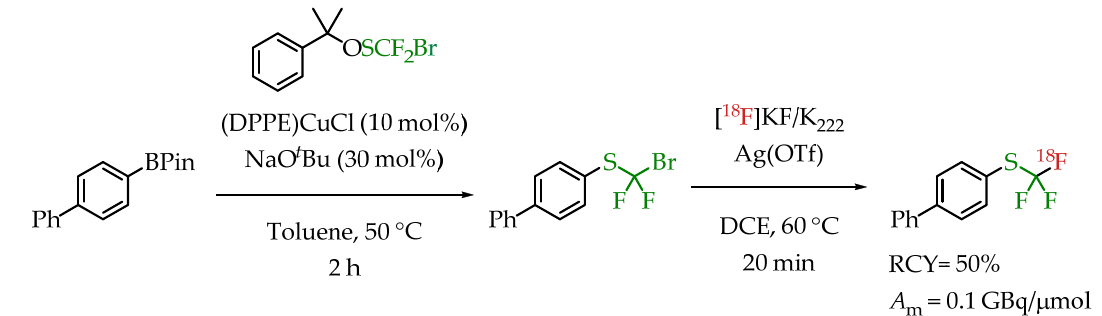
Scheme 19. α -Cumyl bromodifluoromethanesulfenate-mediated [ 18 F]trifluoromethylthiolation of boronate esters. (RCY: Scheme 19. α‐ Cumyl bromodifluoromethanesulfenate ‐ mediated [ 18 F]trifluoromethylthiolation of boronate esters. (RCY: radiochemical yield; A m : molar activity.) radiochemical yield; A m : molar